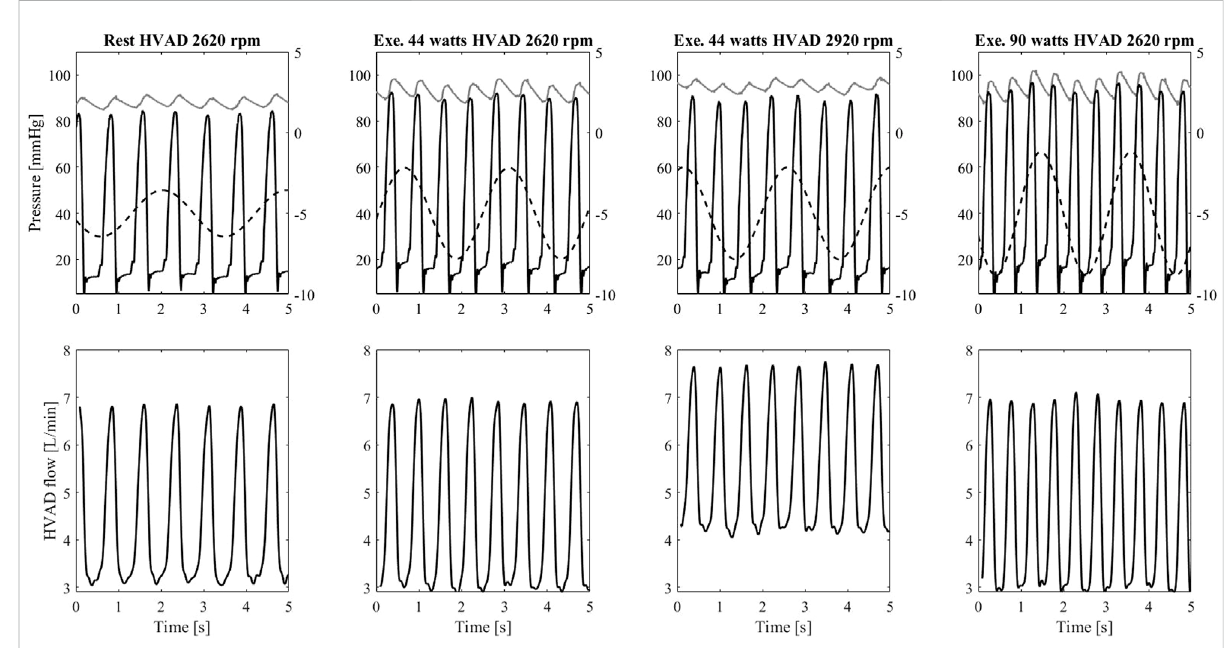
FIGURE 9 Upperpanel:leftventricularpressure(black),ascendingaortapressure(grey),andintrathoracicpressure(dashedlineplotagainstthesecondary y -axis)measuredonthesimulator.Lowerpanel: fl owwaveformsmeasuredfromtheHVADconnectedtothesimulator.Datafromthelefttotheright column refers to: rest condition with HVAD at baseline speed Group1 exercise (44 W) with HVAD at baseline speed, Group1 exercise (44 W) with HVAD at increased speed, Group2 exercise (90 W) with HVAD at baseline